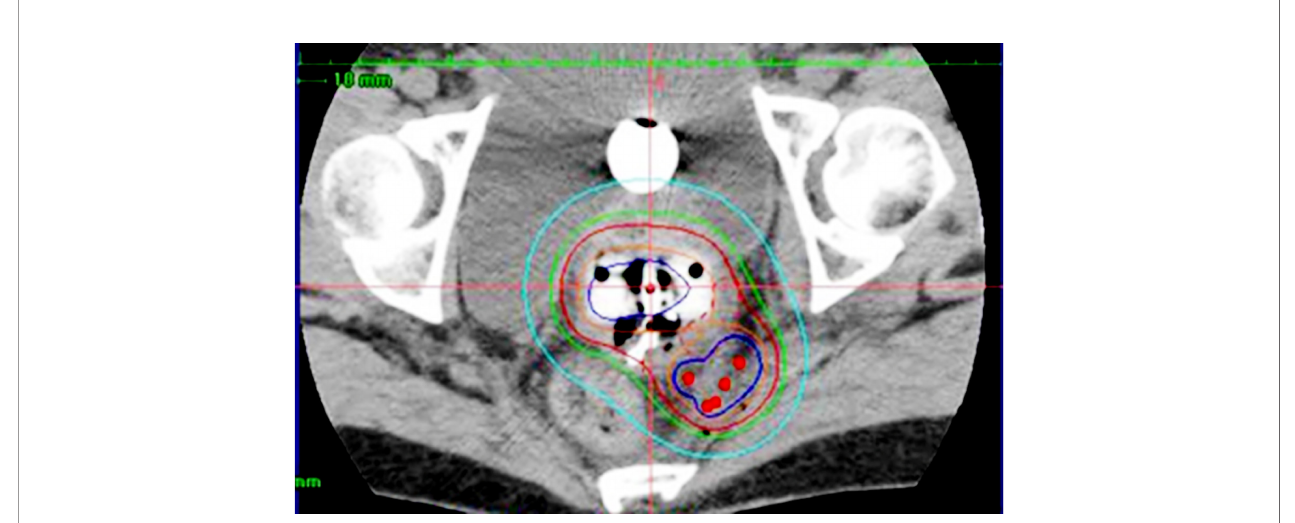
FIGURE 3 | Hybrid brachytherapy of cervical cancer extending along the left uterosacral ligament. Five red dots posterolateral to the intracavitary applicators are perineal interstitial applicators, with which good coverage of the uterosacral invasion is attained.